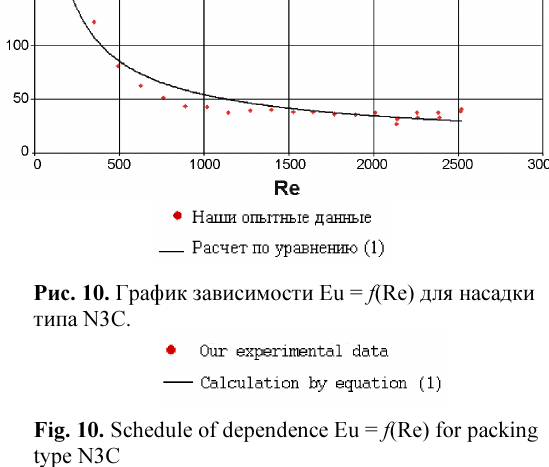
Fig. 10. Schedule of dependence Eu = f (Re) for packing type